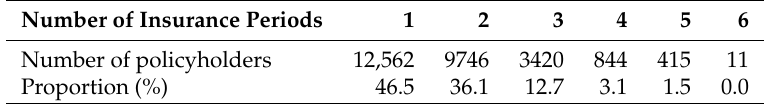
Table 1. Distribution of the number of insurance periods for the